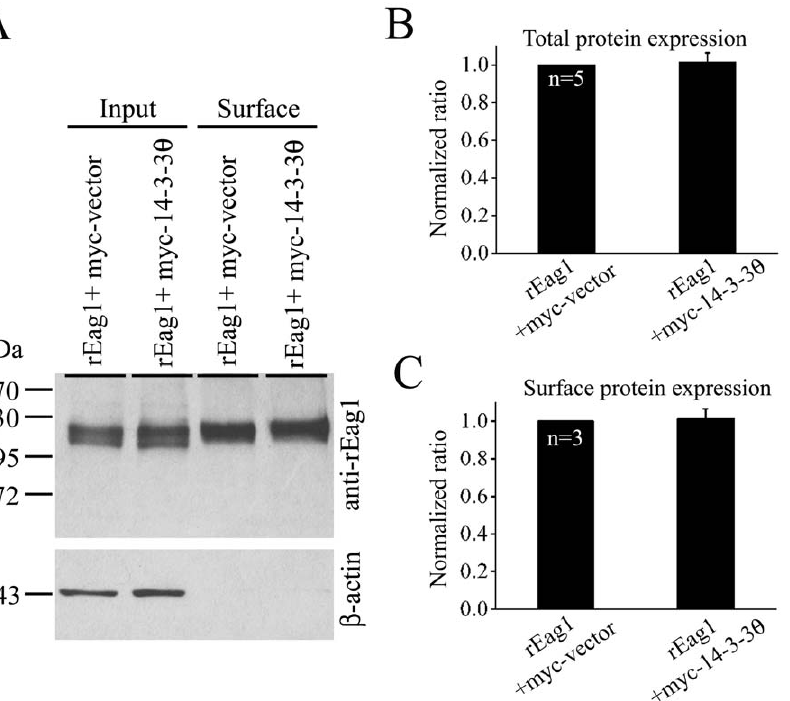
Figure 9. Lack of effect of 14-3-3 h over-expression on the total and surface expression of rEag1 protein. ( A ) Representative result of surface biotinylation experiments. Intact HEK293T cells were biontylinated on ice and thereafter solubilized. ( Surface ) Cell lysates were pulled down with streptavidin agarose beads, followed by immunoblotting with the anti-rEag1 antibody. ( Input ) Cell lysates were directly employed for immunoblotting analyses. Input represents 5% of the total protein used for streptavidin pull-down. Also shown at the bottom are the corresponding b -actin expression levels for each lane. The specificity of the biotinylation procedure was verified by the absence of b -actin bands in the surface fraction. ( B ) Quantification of total and surface expression of rEag1 in the absence or presence of 14-3-3 h over-expression. The total protein density ( top panel ) was determined as the ratio of input signal to the cognate b -actin signal. The surface expression efficiency ( bottom panel ) was expressed as the ratio of surface signal to the corresponding total protein density. The mean values were subsequently normalized with respect to that of vector control. Densitometric scans of immunoblots were obtained from three independent experiments.